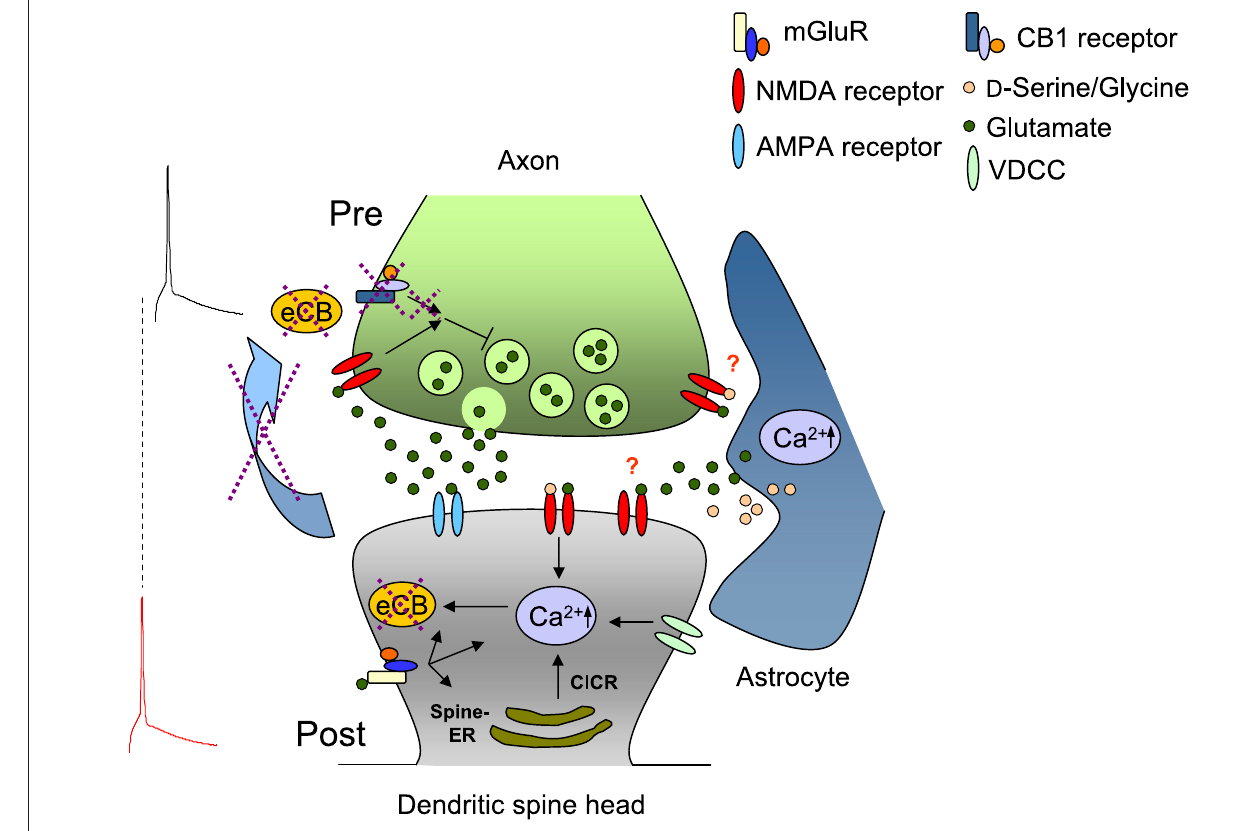
glutamate release from the presynaptic terminal. Astrocytic release of gliotransmitters (glutamate as agonist and/or D-serine or glycine as co-agonist) may contribute to activating neuronal NMDA receptors. Model 2: In a second model, eCB-dependent retrograde signaling is not necessary for induction of t-LTD (dashed crosses), and activation of presynaptic NMDA receptors alone appears to be sufficient to drive presynaptic t-LTD. The source of transmitter activating presynaptic NMDA receptors is